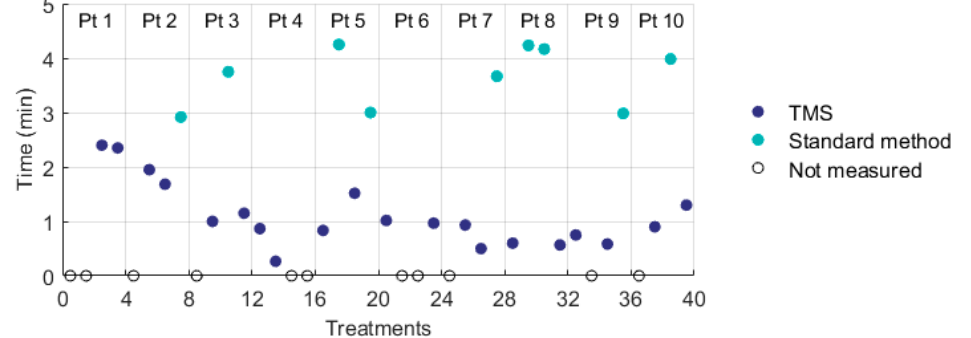
Figure 10. The duration to position skin surface temperature sensors with the thermal monitoring sheet (TMS) and with the Amsterdam UMC standard method for thermometry.